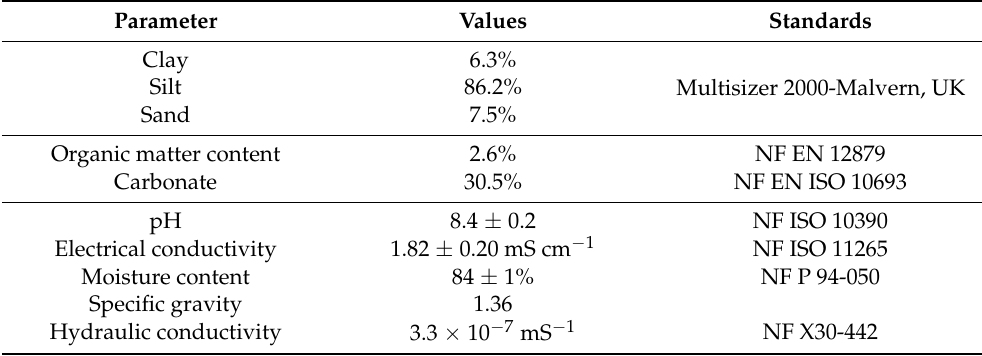
Table 1. Properties of the dredged